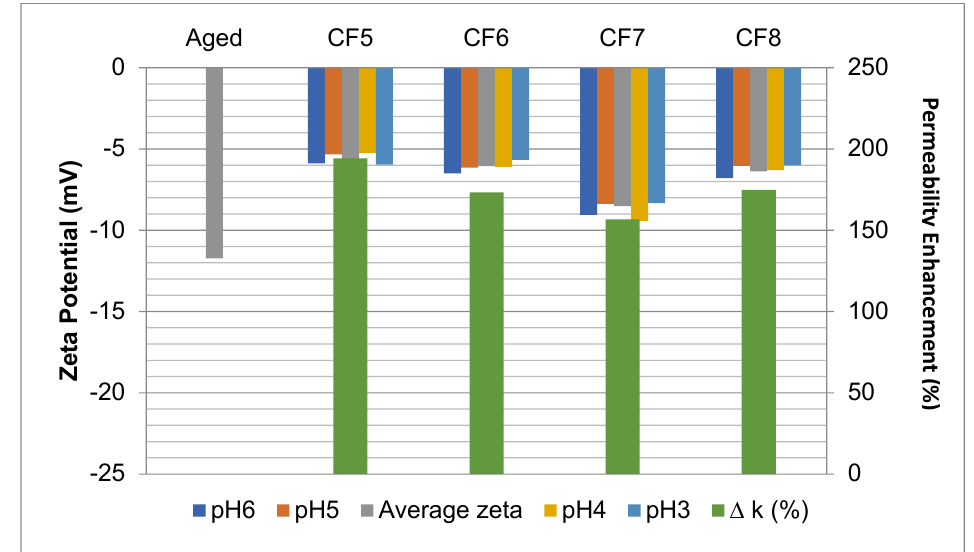
Figure 19. Zeta potential (pH3 to pH6) vs. permeability enhancement (category2).